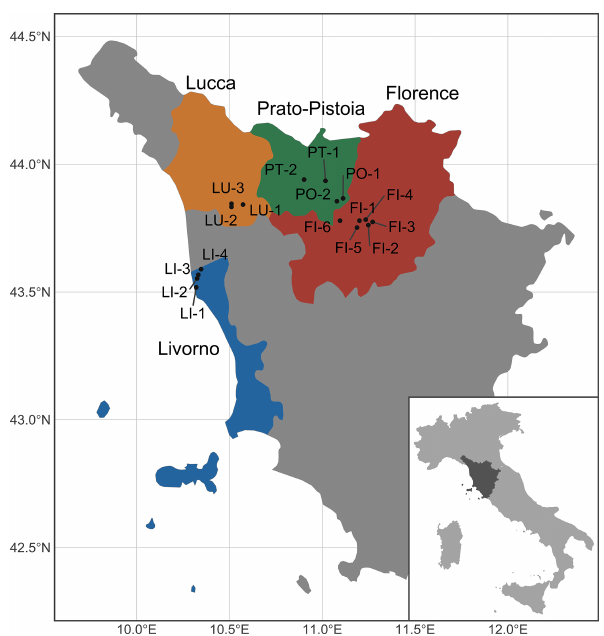
Figure 1. The locations of the 17 sampling sites divided into the four metropolitan